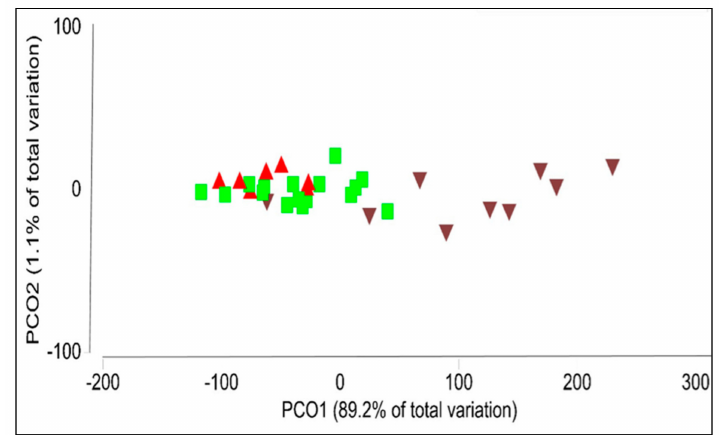
Figure 3. Principal coordinates showing similarities between communities of bacterial endophytes from di ff erent tissues in Pseudowintera colorata . Leaf: green square; stem: red upright triangle; root: brown inverted